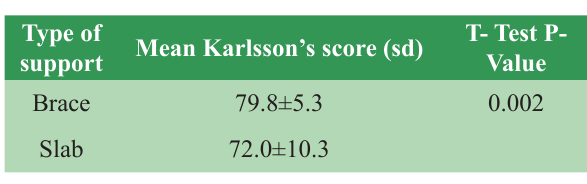
Table 5: Result of